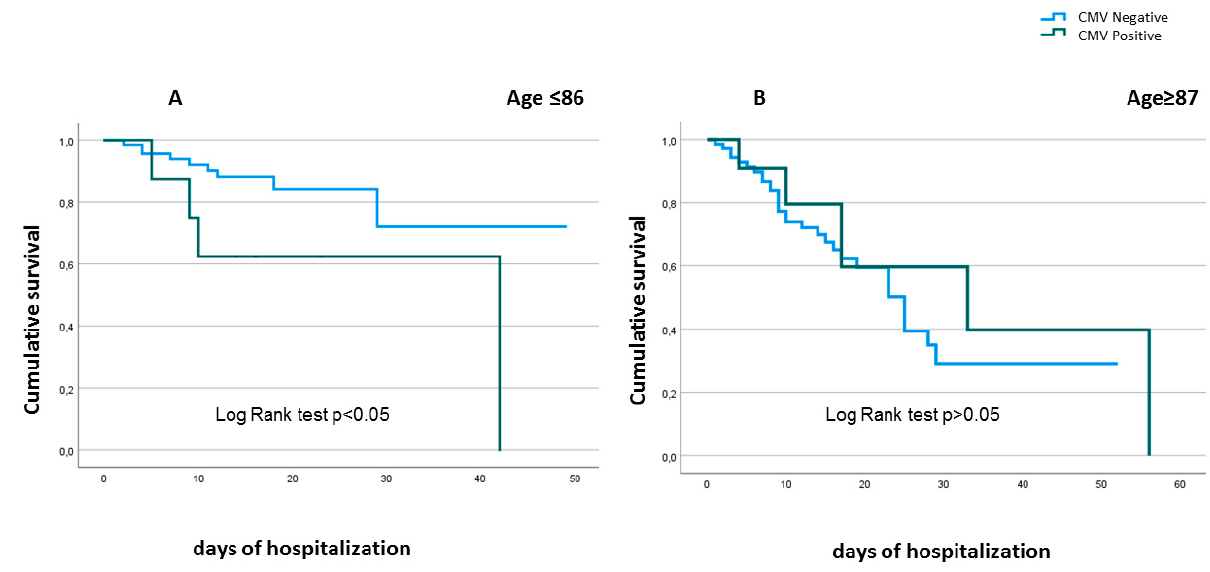
Figure 1. Kaplan–Meier survival estimates according to CMV reactivation in old COVID-19 patients stratified by age. Kaplan-Meier plots comparing in-hospital mortality between CMV positive (green line) and CMV negative patients (blue line). Panel A: Patients younger than 87 years with CMV reactivation had a lower survival than CMV negative ones. Panel B: CMV reactivation was not a predictor of in-hospital death in nonagenarian pa-tients.CMV reactivation was also associated with increased IFN- α and TNF- α serum levels, while no difference was observed for IL-6 and IL-10 serum concentrations in the whole patient cohort (Figure 2).